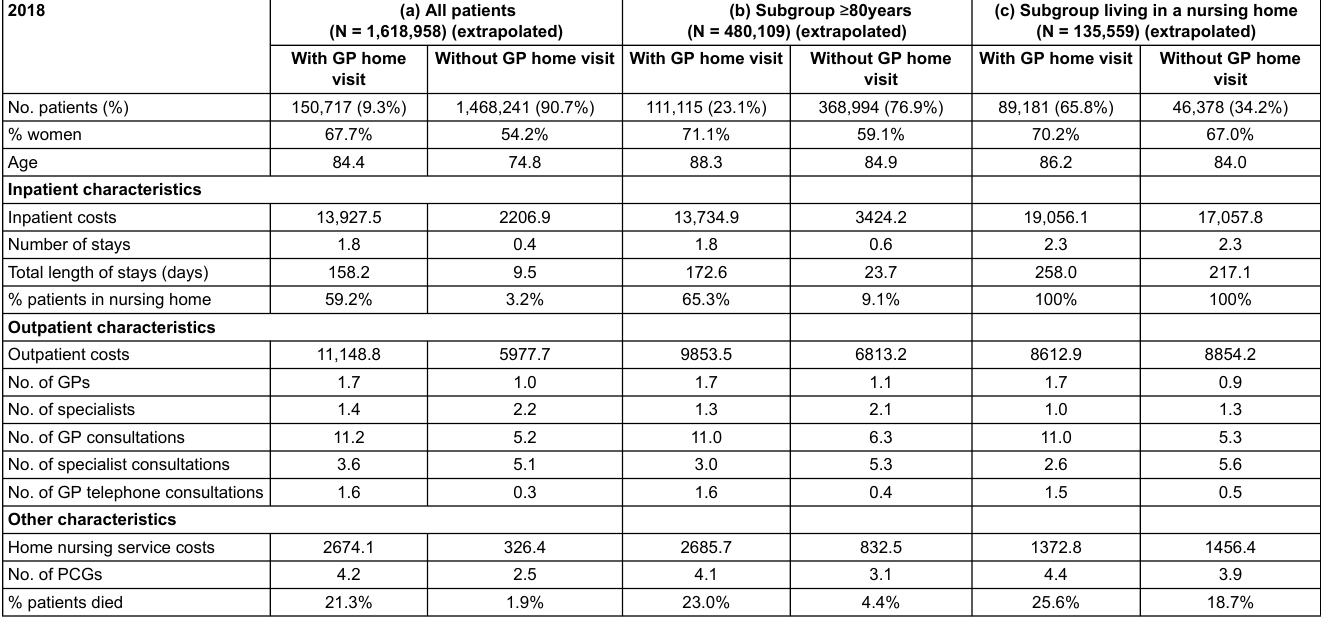
Table 2: Patient characteristics with regard to health conditions and healthcare utilisation (year 2018) for (a) overall patients in the Swiss population (extrapolated) (aged ≥65 years); (b) subgroup of patients ≥80 years; (c) subgroup of patients living in a nursing home in the same year, 2018.